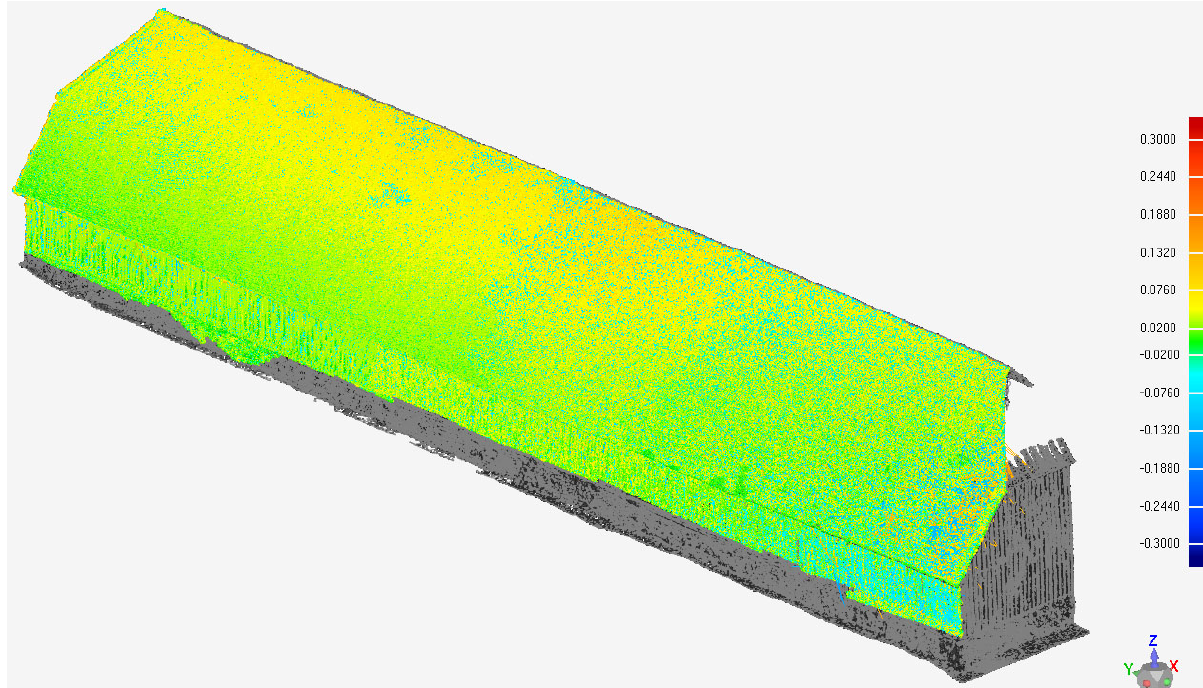
Fig. 4 Differences between the laser scan and SFM point clouds. The difference tends to increase towards the ridge due to the laser scans only being obtained from the ground while a mast was used for the photography. the techniques in a complementary fashion, combining the re- sults of the two, and using one to fill in where the other is weaker and vice versa. The use of the same coordinate frame for both methods allows this to take considerably less time than a best fit estimation of the point clouds or meshes. Photography of details taken inside the barn to record certain features